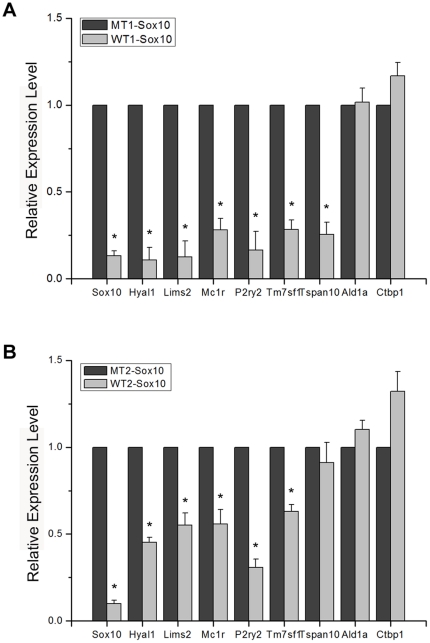
Confirmation of microarray expression profiling.(A) Quantitative real time RTPCR assays were carried out using B16F10 cells transfected with the MT1-Sox10 or WT1-Sox10. A subset of genes that showed down-regulation by WT1-Sox10 in the microarray assay by 2.5 fold or higher in all triplicates (Table 1) and two non-target genes whose expression levels were unchanged (Ald1a and Ctbp1) were used to validate the results from the microarray assay. The effect of Sox10 knockdown by the specific siRNA on the expression level of each target gene is expressed relative to that of the control siRNA after normalization with GAPDH expression level. Values represent the average of three independent real-time PCR experiments each carried out in duplicates, and error bars represent standard deviations. (B) Real time RTPCR carried out with MT2-Sox10 and WT2-Sox10. The asterisk (*) represents a significant difference with the p value of <0.05.